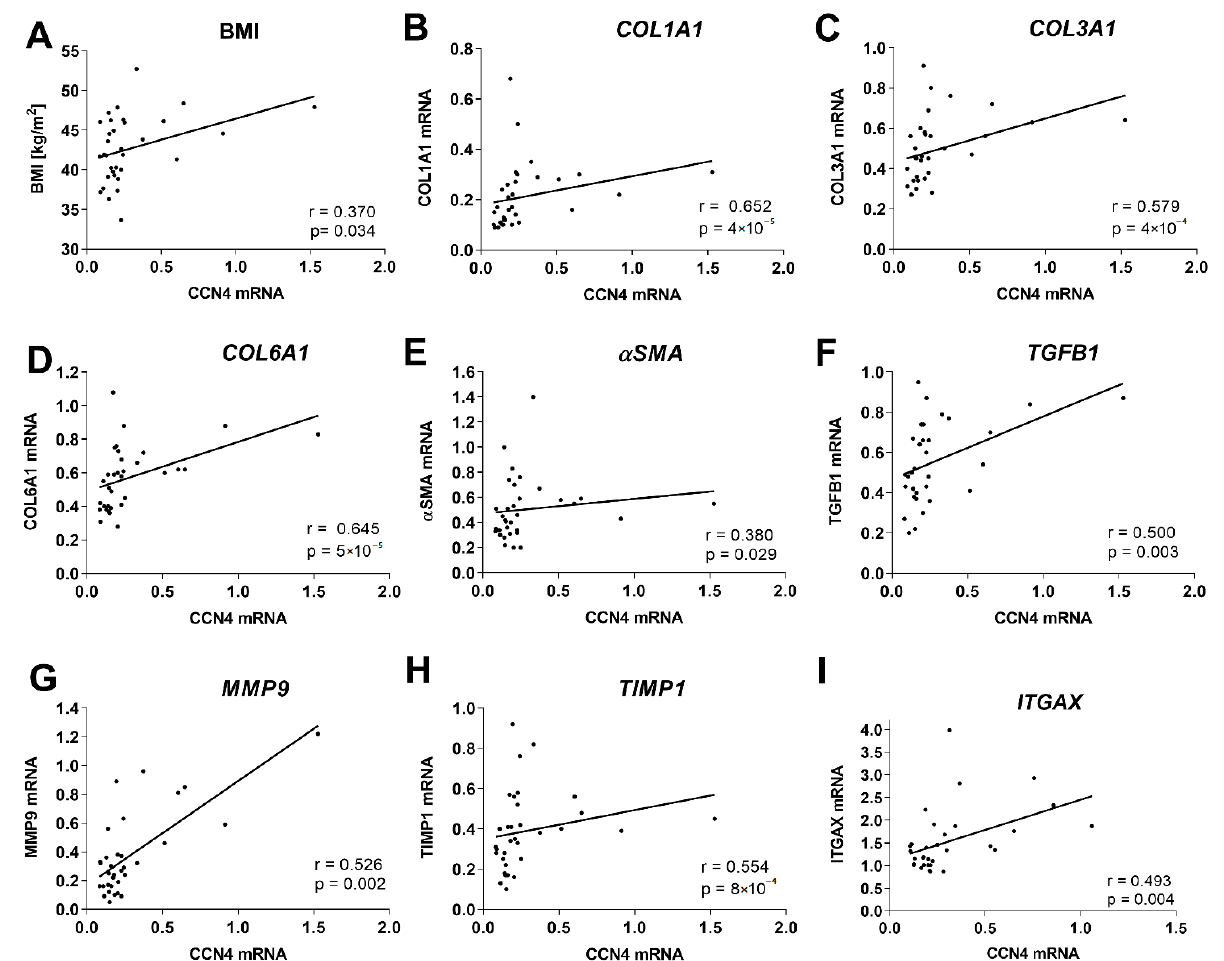
Figure 1. Association of CCN4 with fibrosis markers in human liver. Correlations of CCN4 mRNA expression with ( A ) BMI, ( B ) COL1A1, ( C ) COL3A1, ( D ) COL6A1, ( E ) αSMA, ( F ) TGFB1, ( G ) MMP9, ( H ) TIMP1 and ( I ) ITGAX ( n = 35).